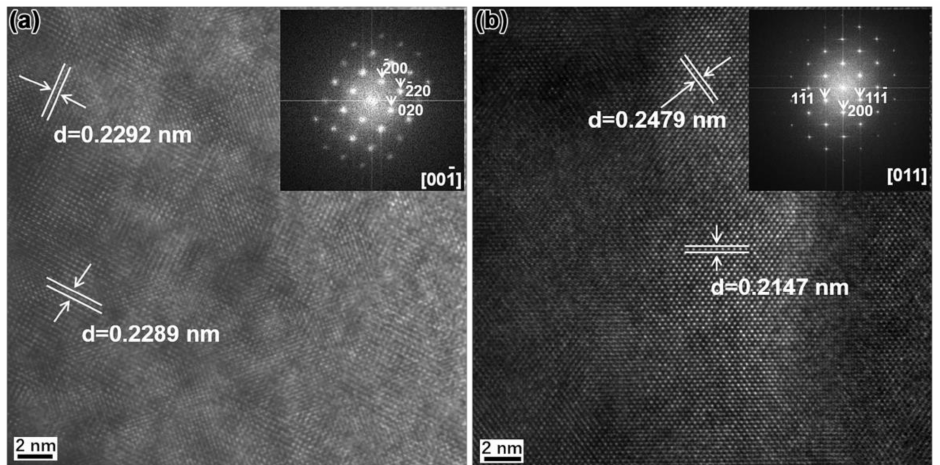
Figure 15. ( a ) HRTEM image of Nb(C, N) in N1 steel, ( b ) HRTEM image of (Nb, Mo)(C, N) in N4 steel. The corresponding Fast Fourier Transform (FFT) images are shown in the